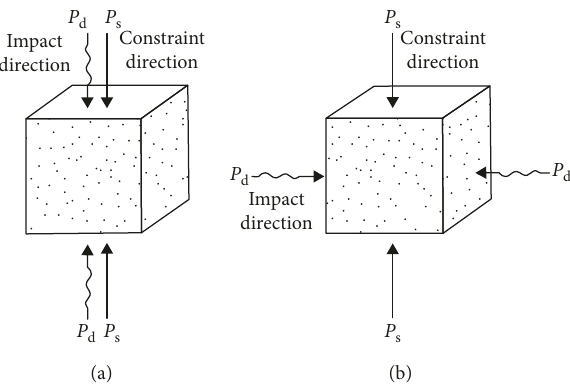
Figure 1: Unilateral constraint dynamic impact